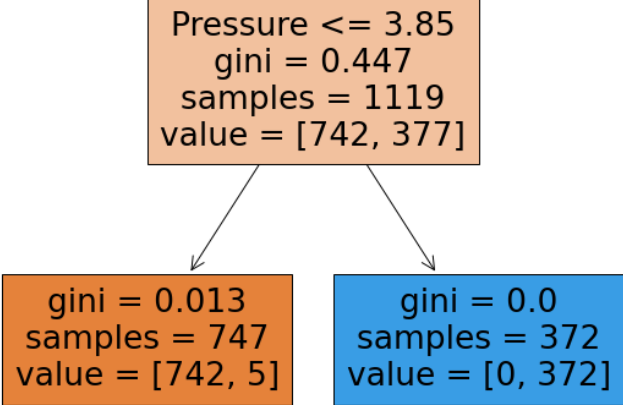
Figure 12. Pump DT. Figure 12. Pump